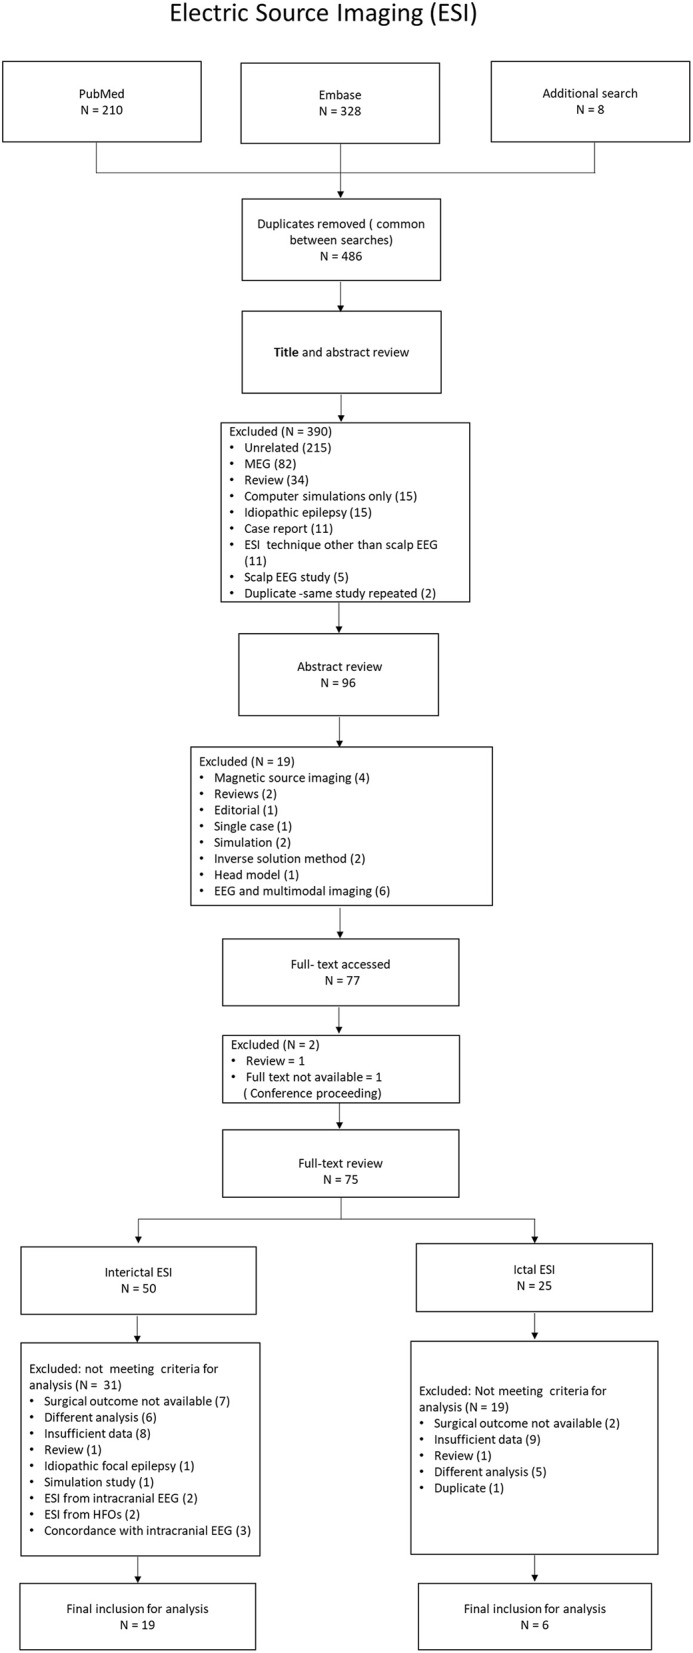
Flow diagram of the studies on ESI, retrieved for the review.